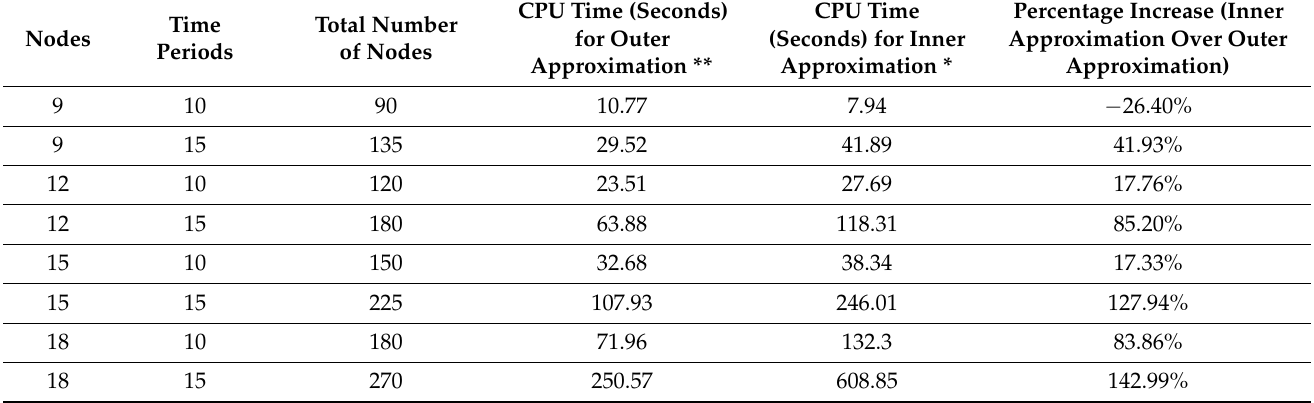
Table 9. DPPNL computation time.